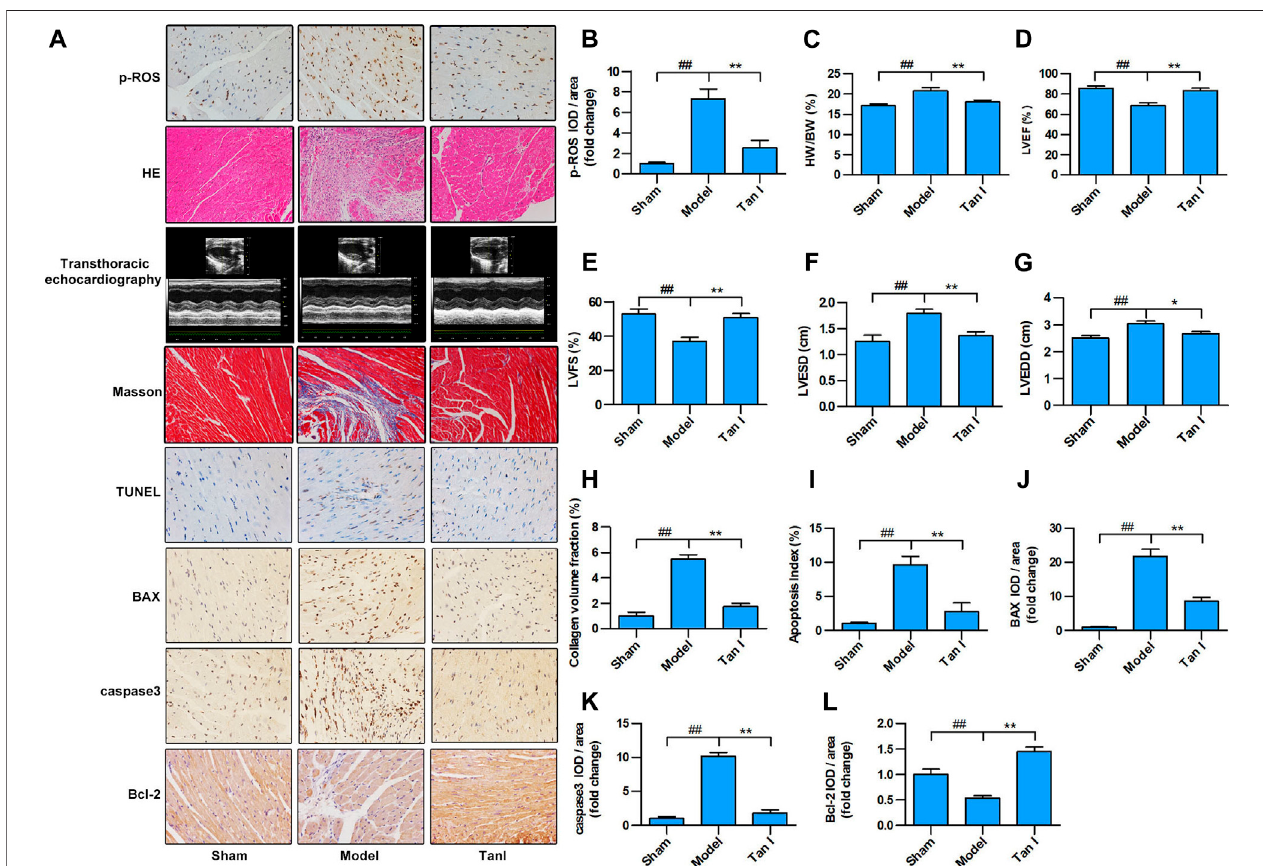
FIGURE 5 | Tan I inhibits ISO-induced myocardial injury in a mouse model. Intraperitoneal injection of ISO was performed to establish an oxidative stress – induced myocardial damage model. (A) Hematoxylin – eosin (HE) staining; Masson ’ s trichrome staining; and immunohistochemistry (IHC) analysis, including p-ROS, BAX, caspase3, and Bcl-2; TUNEL analysis; and transthoracic echocardiography analysis. (B) Relative expression of p-ROS. (C) Heart weight/body weight ratio. (D) Left ventricular ejection fraction (LVEF). (E) Left ventricular fractional shortening (LVFS). (F) Left ventricular end-systolic dimension (LVESD). (G) Left ventricular end- diastolic dimension (LVEDD). (H) Collagen volume fraction. (I) Apoptotic index. (J) Relative expression of BAX. (K) Relative expression of caspase3. (L) Relative expressionofBcl-2.Dataarepresentedasmean ± S.D. # p < 0.05, ## p < 0.01 ,comparedtotheshamgroup. *p < 0.05 , **p < 0.01 ,comparedtothemodelgroup( n (cid:2)